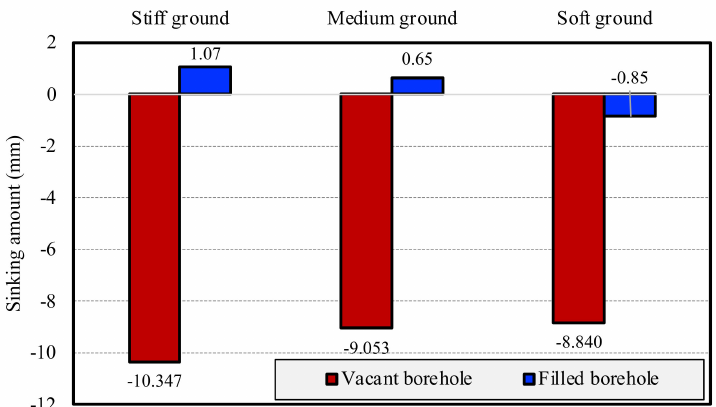
Figure 9. Comparison of sinking amounts for vacant and filled cases of double boreholes.